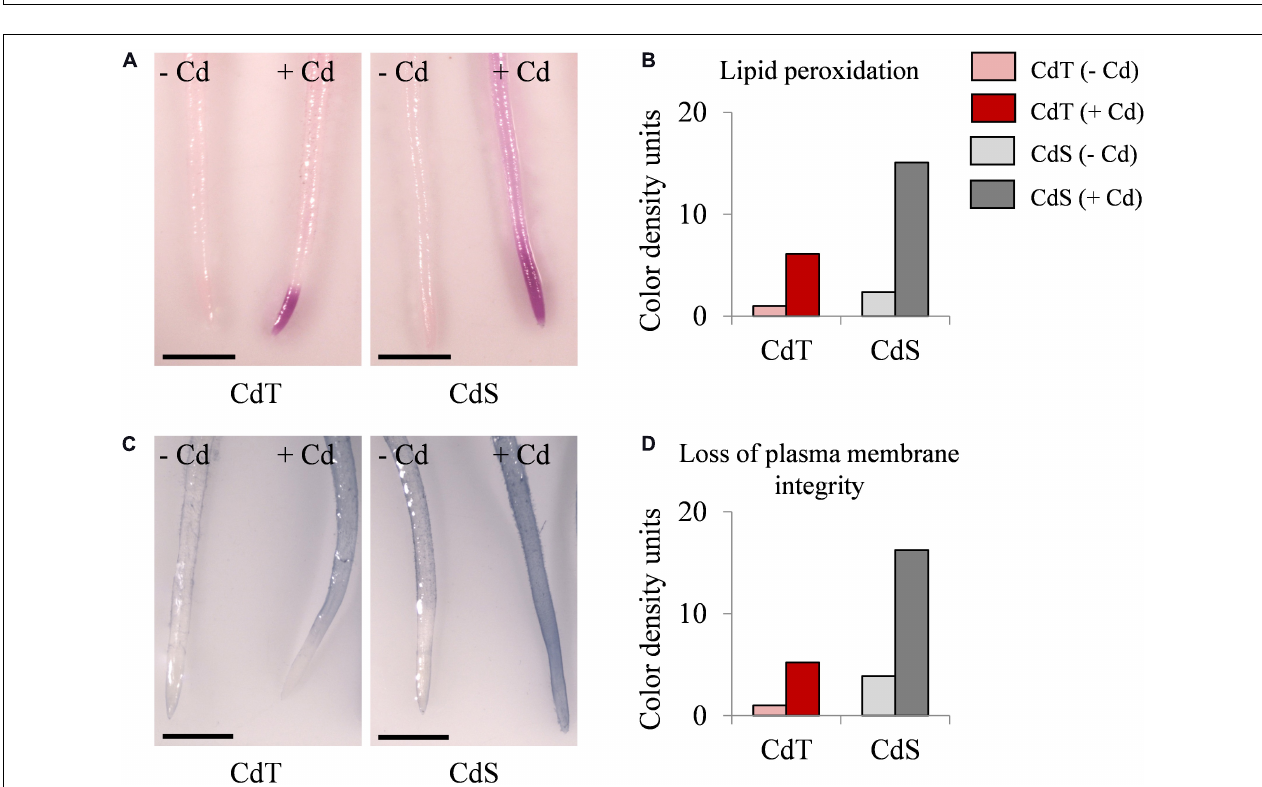
FIGURE 7 | Oxidized glutathione (GSSG) (A) , reduced glutathione (GSH) (B) , and GSH/GSSG ratio (C) in seedling roots of M. truncatula cultivars CdT (tolerant) and CdS (sensitive) grown in glass containers in the absence or presence of 50 µ M CdCl 2 for 12 h. Mean values ± standard deviation are represented. Different letters indicate significant differences (Tukey HSD test, p ≤ 0.05, n = 4). * Denotes significant differences between control and Cd treatment.